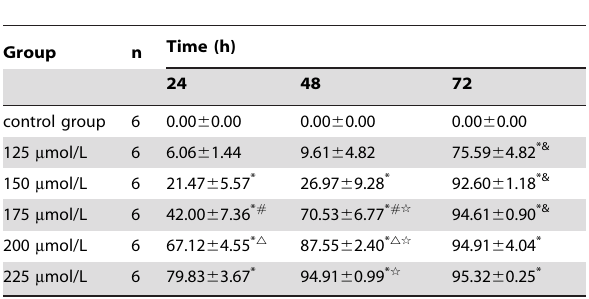
Table 1. Inhibition rate of Artesunate on HSCs under different concentrations and time (%, x 6 s).